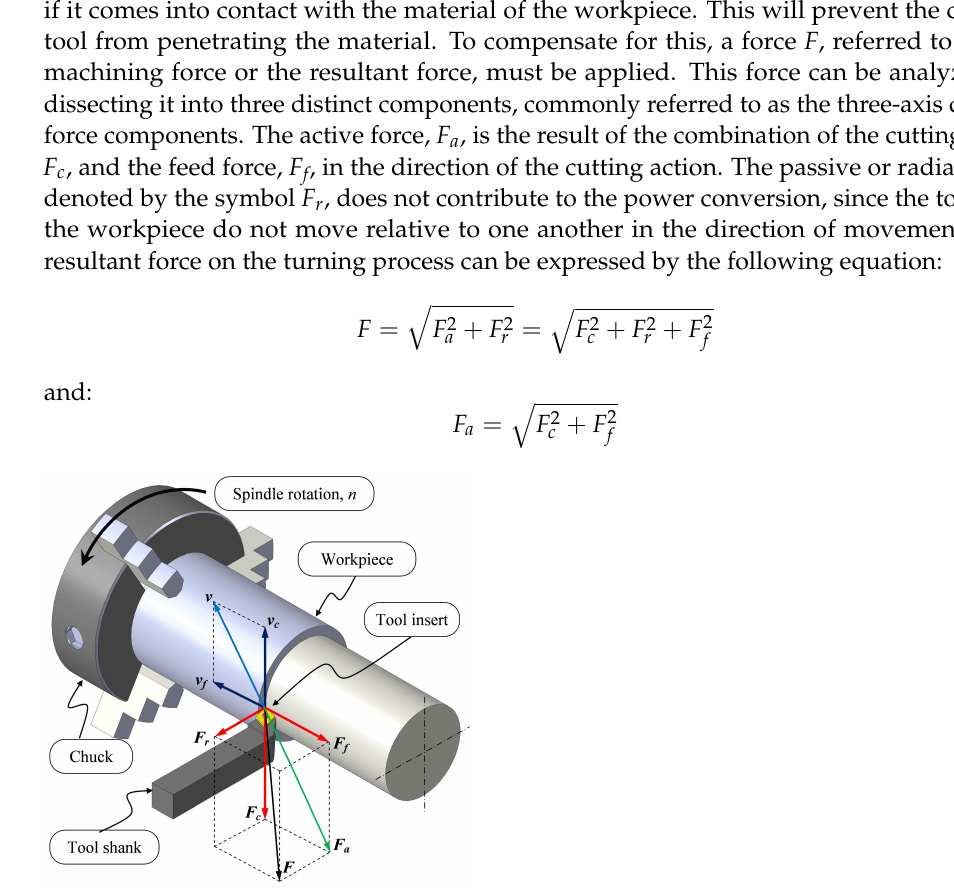
Figure 1. Three axes of the cutting force components in a turning